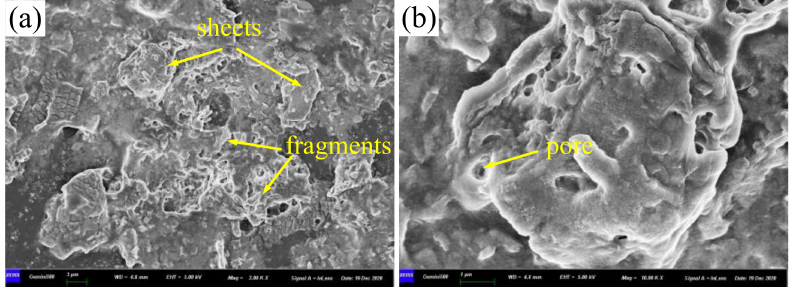
Figure 6. SEM images of lanthanum stearate. ( a ) 2.0 × 10 3 times; ( b ) 1.0 × 10 4 times.